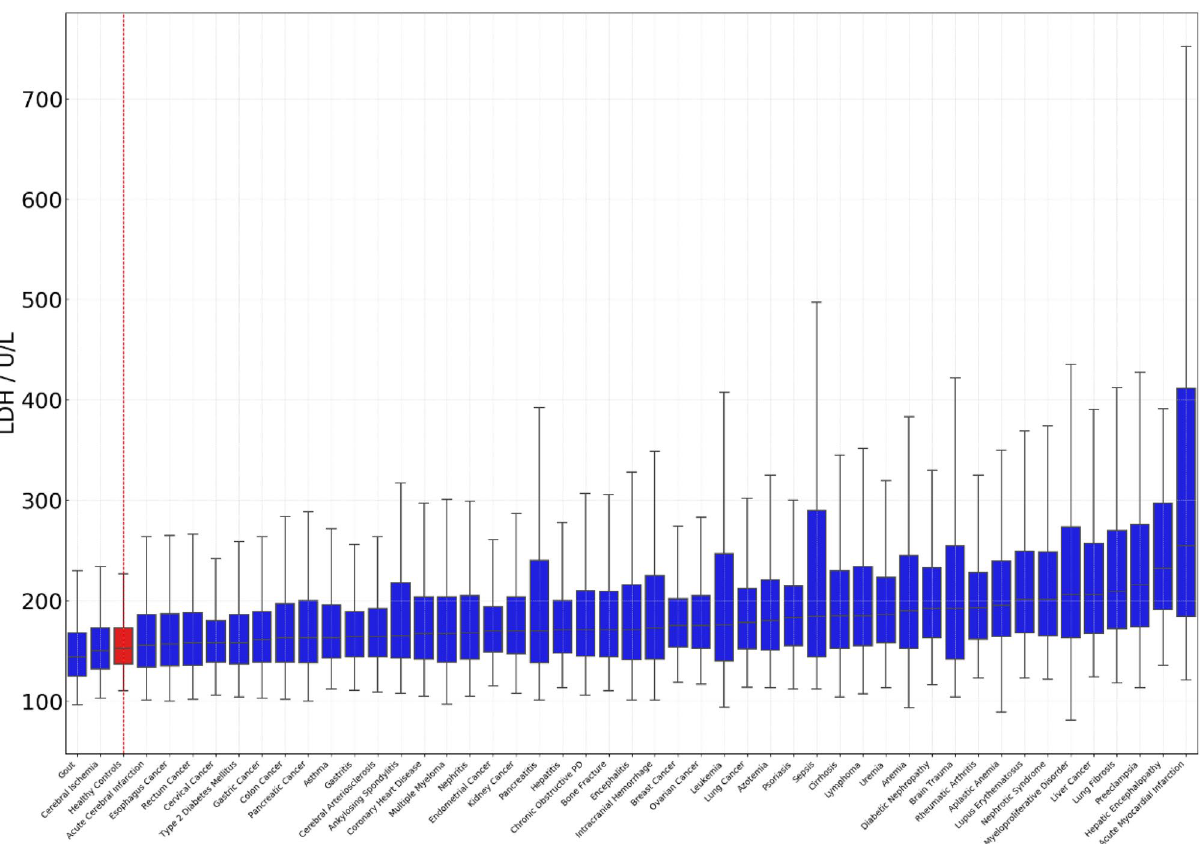
Figure 1. Serum LDH activities in 48 different types of diseases. The average in red would be that of the control group. The data were sorted in ascending order according to the median values. Chronic obstructive PD chronic obstructive pulmonary